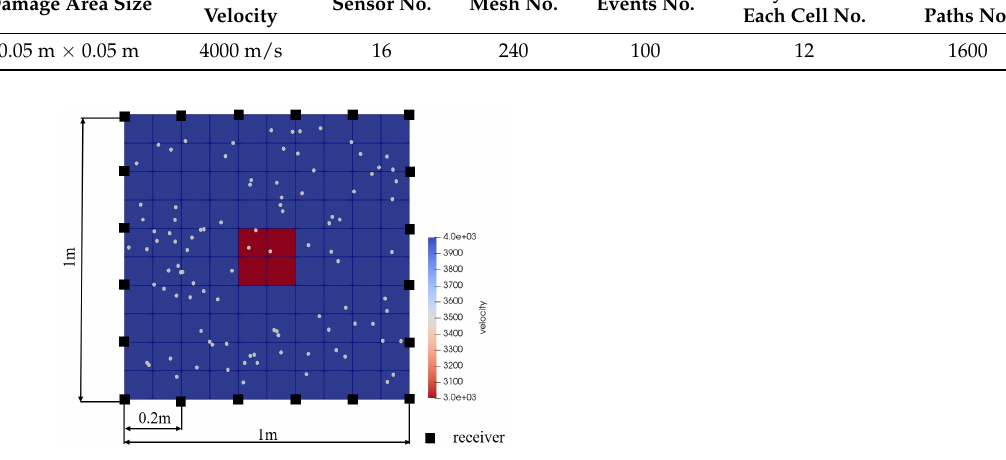
Figure 9. Original distribution for the damage target in case 2. Table 3. Model information for case 2.